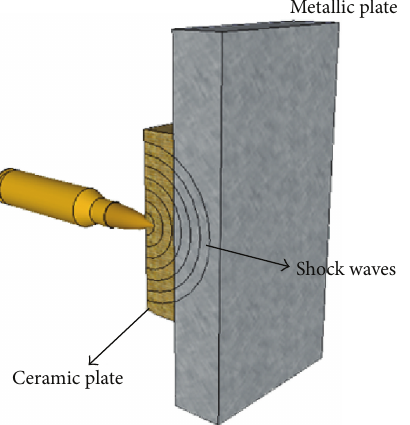
Figure 1: Proposal of a two-layer protection made by Gonc¸alves et al. [1].